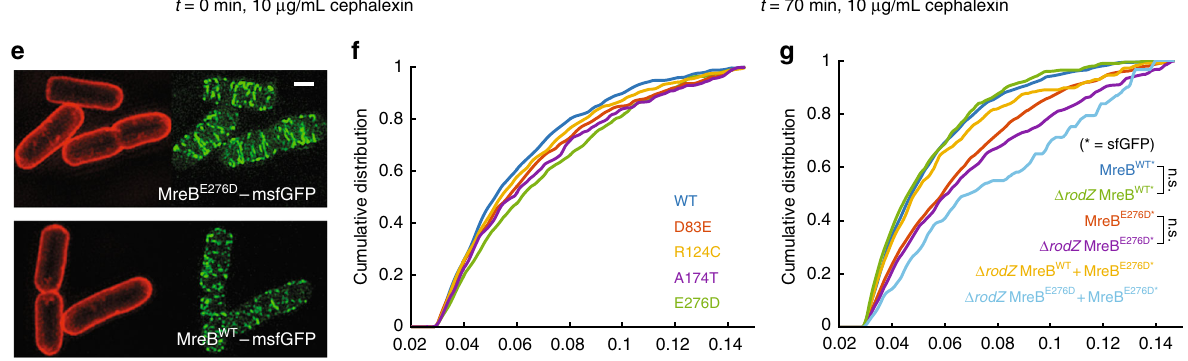
of conformations adopted by MreB dimers in silico, we predict that the binding of RodZ to a fraction of the MreB subunits, which will be related at least in part to the stoichiometry of MreB and RodZ (Fig. 2a), causes altered curvature sensing of MreB in vivo.